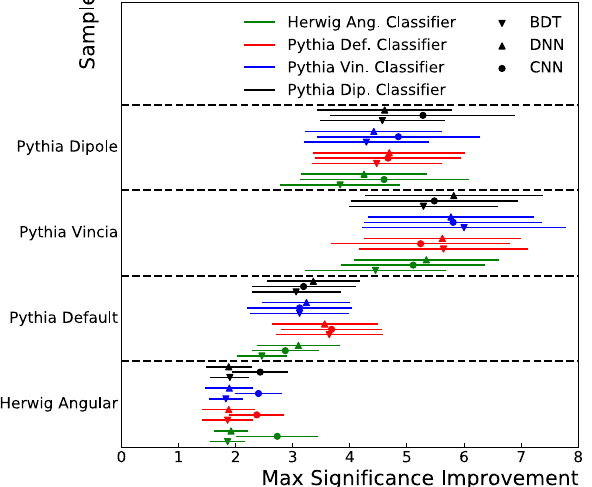
Fig. 7 The performance of classifiers as quantified by the maximum significance improvement when training on a given PSMC (color) and testing on the PSMC specified on the vertical axis. The symbols repre- sent the type of model (BDT, DNN, CNN). The error bars represent the standard deviation over the k